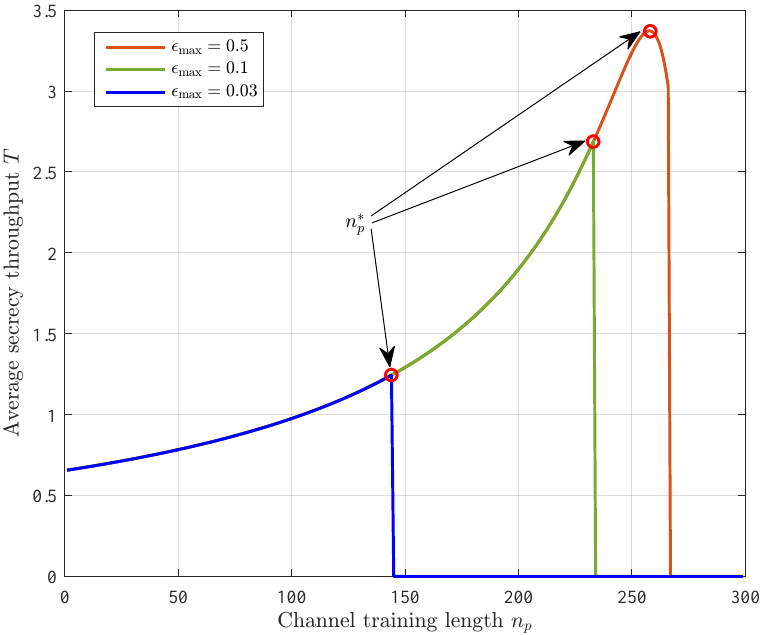
Figure 7. The average secrecy throughput T versus the channel training length n p under the reliability constraint, where α = 0.5, n = 300, ρ = 10 dB, ¯ γ sd = 20 dB, and ¯ γ se = 0